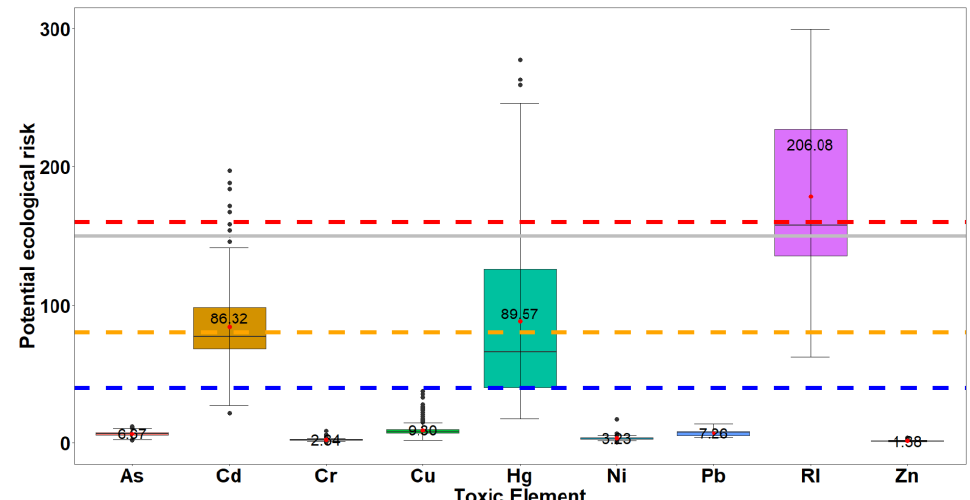
Figure 4. Boxplot of values of potential ecological index (the number represents the mean value of potential ecological index of different TEs; the blue dashed line represents threshold value of low risk; the orange dashed line represents threshold value of moderate risk; the red dashed line represents threshold value of high risk; the grey solid line means the threshold of low risk for RI). Table 3. Pollution status assessed by potential ecological risk assessment index ( n = 300).